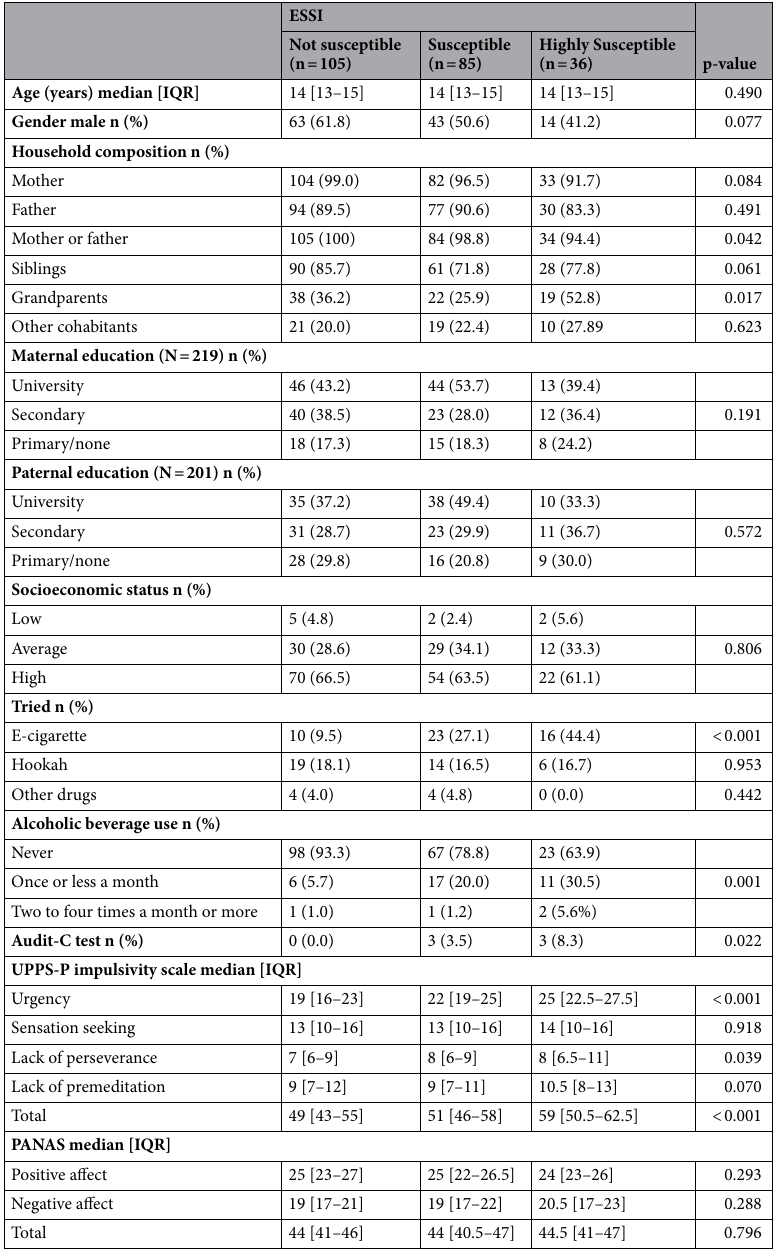
Table 3. Comparison of variables according to the Expanded Susceptibility to Smoking Index (ESSI) values for students who had not tried cigarettes. IQR: interquartile range; UPPS-P: impulsive behaviour scale; PANAS: positive and negative affect